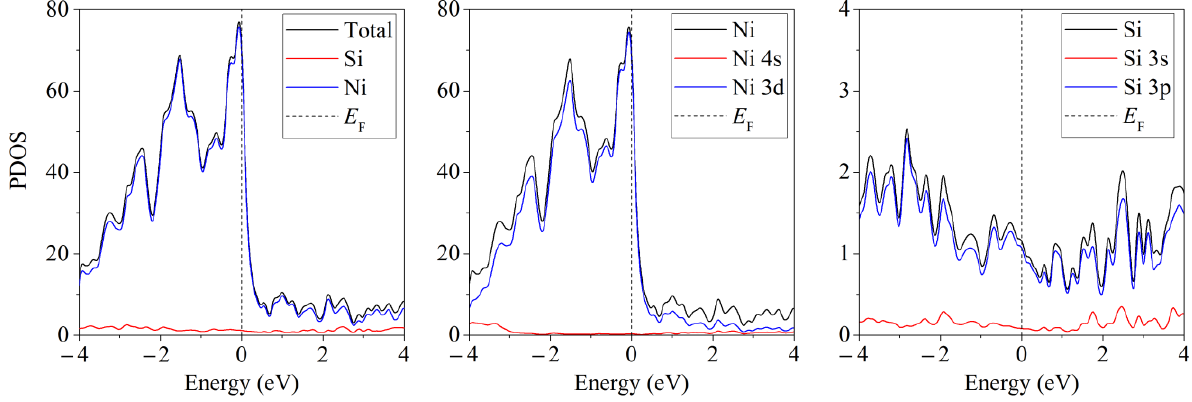
Figure 8. Partial spectra of electronic states of the “silicene/nickel substrate” system; the substrate contains 4 layers of Ni. Reprinted with permission from Ref. [45]. 2021, Elsevier.